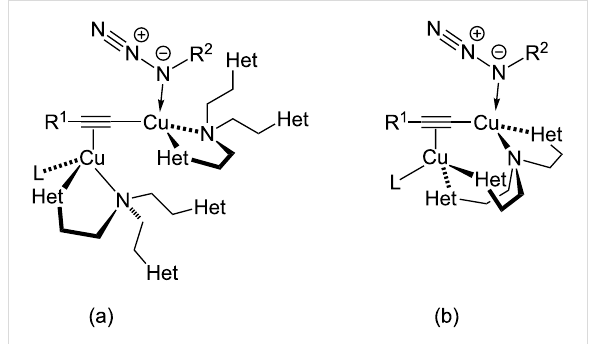
Figure 5: Acetylide-bridged dicopper complexes with tris(heteroaryl- methyl)amine ligand(s) as key intermediates in the CuAAC reaction: (a) two tris(heteroarylmethyl)amine ligands bind to one copper centre each [81]; (b) one tris(heteroarylmethyl)amine ligand binds to both copper(I) centres [28,42] (L = halide, acetylide, hydroxide, triflate, or a neutral ligand, which would give a positive charge on this copper centre; Het = N -heterocyclic substituents such as benzimidazolyl, tria- zolyl, pyridyl or benzothiazolyl in the tripodal ligand; for